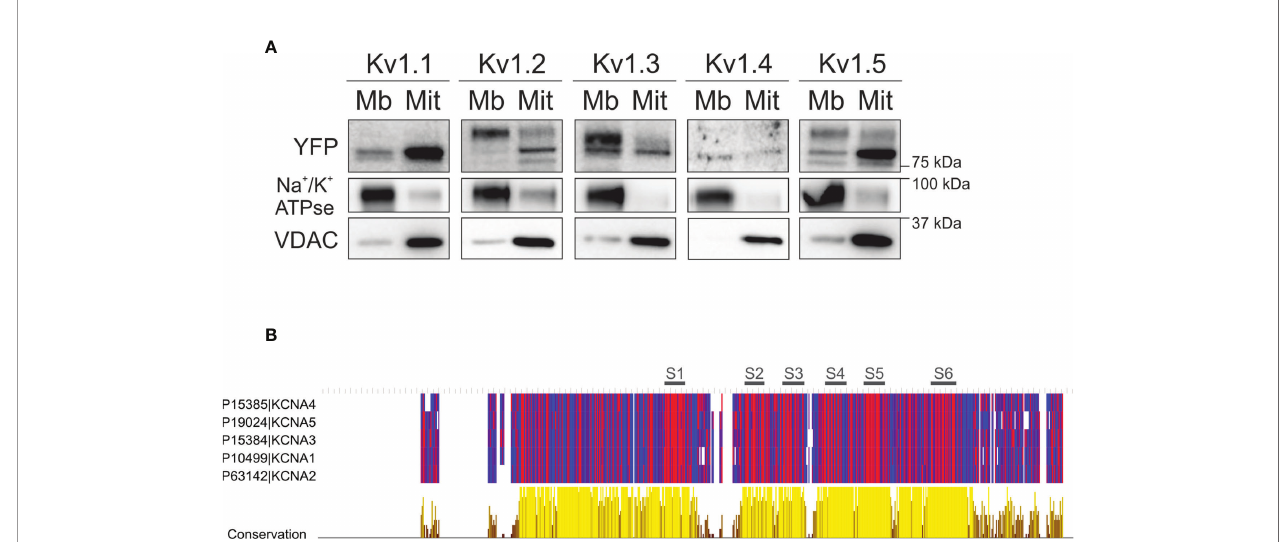
FIGURE 4 | Transmembrane domains are candidate determinants of the mitochondrial import of Shaker channels. HEK 293 cells were transfected with Kv1.1- Kv1.5YFP channels, and mitochondrial expression was analyzed. (A) Membranous (Mb) and mitochondrial (Mit) fractions of HEK 293 cells transfected with the indicated member of the Shaker family. Note a shift in the molecular weights of the Kv1.2, Kv1.3 and Kv1.5 channels between the Mb and Mit fractions. Na + /K + ATPse is used as a plasma membrane marker, and VDAC is used as a mitochondrial marker. (B) Multiple protein sequence alignment of members of the Shaker family of voltage-gated potassium channels performed using Clustal Omega and JalView software. UniprotKB reference numbers are indicated. Hydrophobic residues are indicated in red, and hydrophilic residues are indicated in blue. Conservation among sequences is indicated in yellow. S1-S6 black lines indicate the sequence fragments corresponding to the transmembrane